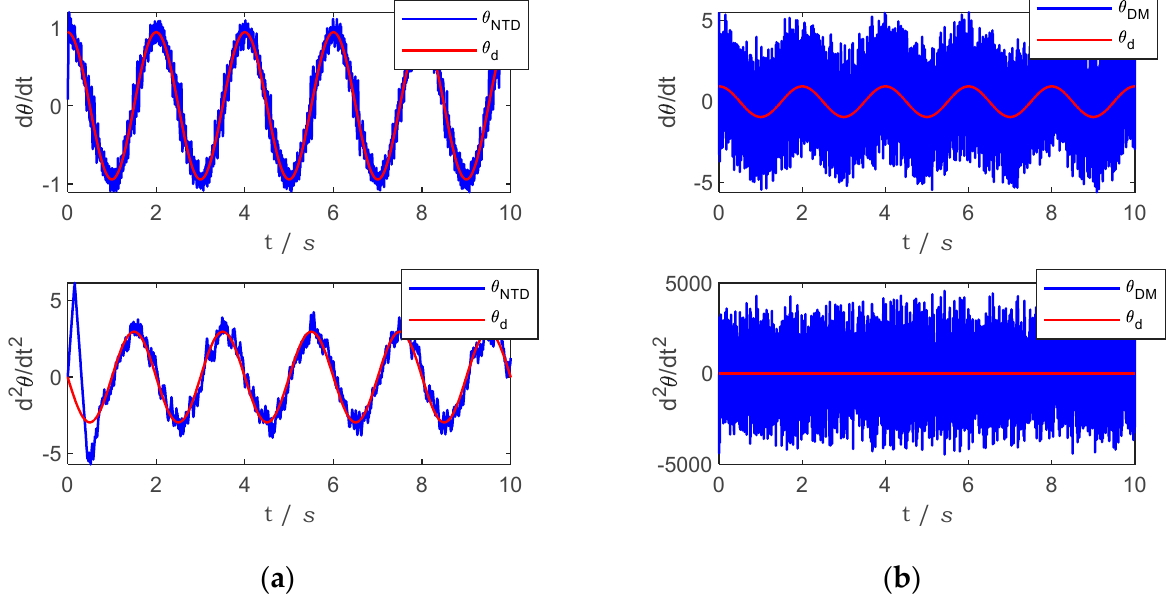
Figure 5. Trajectory (with noise) tracking results by using different method. ( a ) Trajectory tracking by using nonlinear tracking differentiator. ( b ) Trajectory tracking by using the difference method.